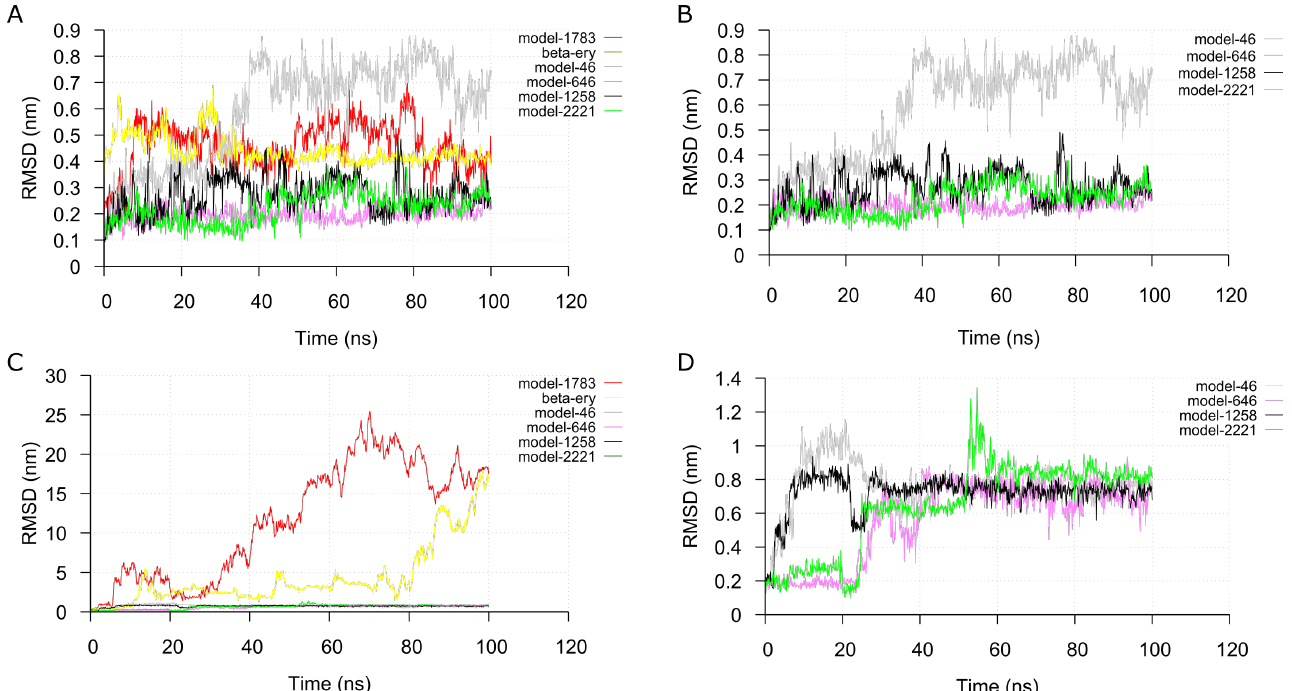
Figure 5. Stability analysis of ligands during simulations. The root-mean-square deviation (RMSD) plot of the compounds in complex with α 6 β 2 ( A , B ) or α 4 β 2 ( C , D ) receptor with respect to their starting structures as a function of simulation time. [beta-erthry =